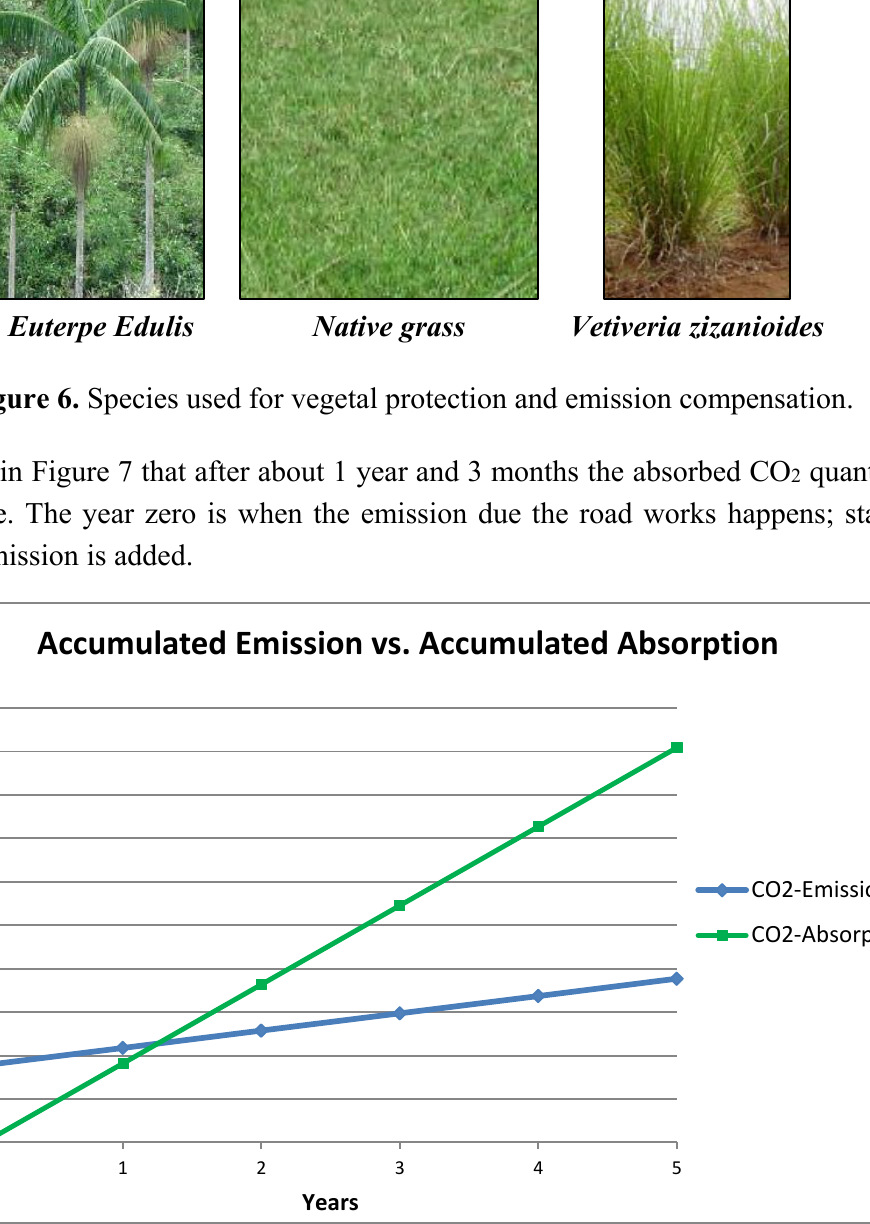
Figure 7. GHG emission